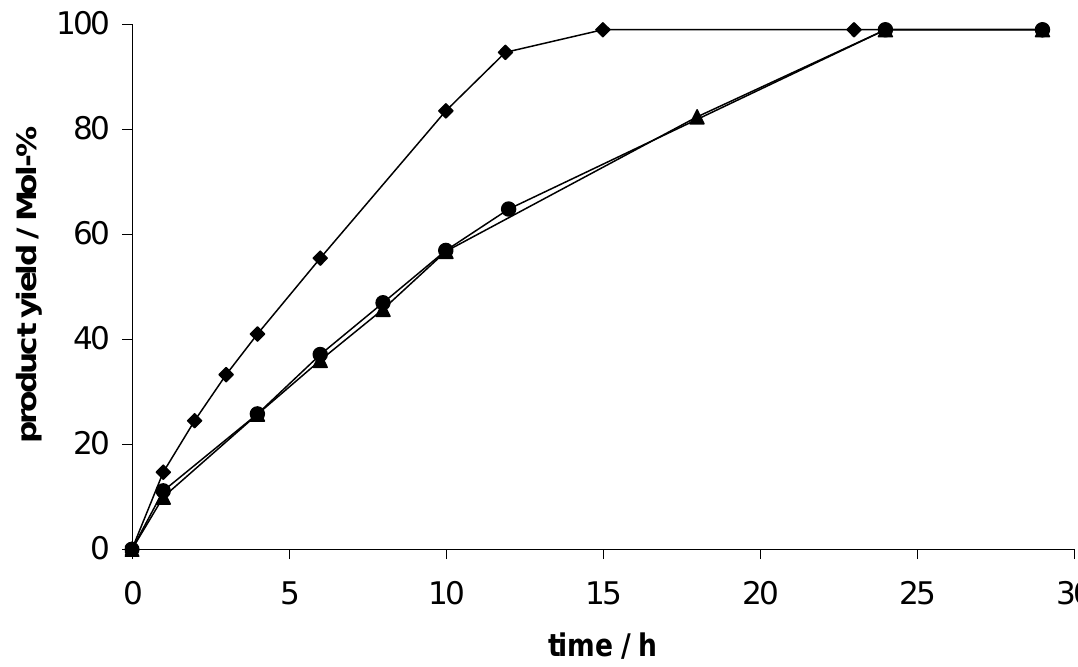
Figure 8. Product concentration during the cyanosilylation of benzaldehyde using EOF-3 (circles), EOF-4 (triangles) and EOF-5 (diamonds) as